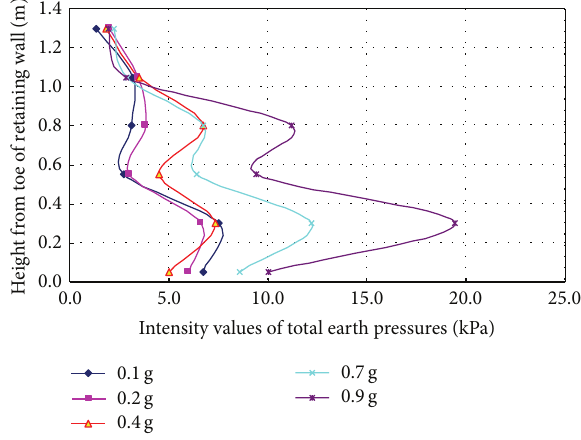
Figure 7: The distribution of total earth